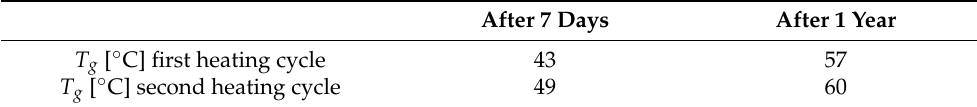
Table 2. Glass transition temperature of EPON 815C/Epicure 3140 measured at room temperature.